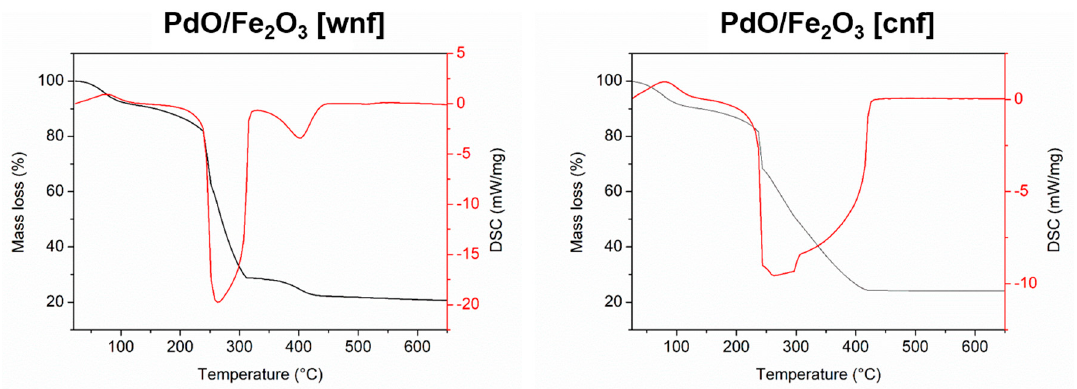
Figure 2. TGA and DSC profiles of PdO/Fe 2 O 3 [wnf] and PdO/Fe 2 O 3 [cnf] samples.